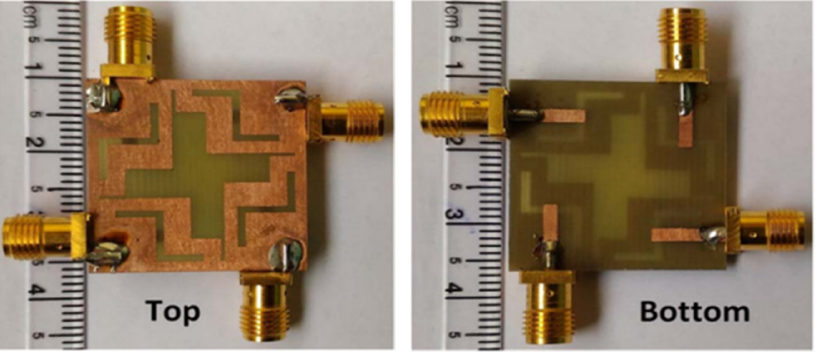
Figure 3. The fabricated prototype of 4 × 4 MIMO antenna [21]. ( Left side : ground plane and right side : microstrip line).